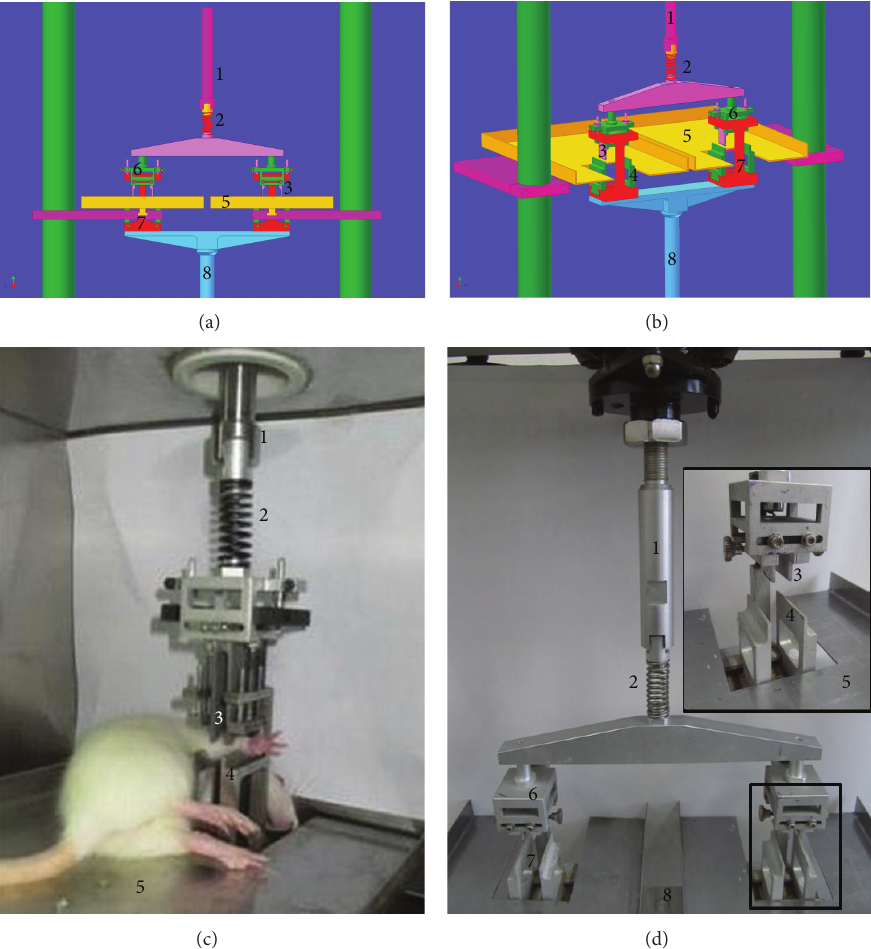
Figure 1: The four-point bending fatigue test apparatus is an open loop system consisting of the following components: (1) upper connecting rod, (2) linear compression spring, (3) upper indenter, (4) lower supports, (5) loading plates where the rat is placed, (6) T-shaped upper indenterslide,(7)C-shapedlowersupportslide,and(8)lowerconnectingrod.Thepictureshowsthefollowing.(a)Frontviewoftheapparatus. (b) Lateral view. (c) Fixture with a single rat. (d) Fixture system for two